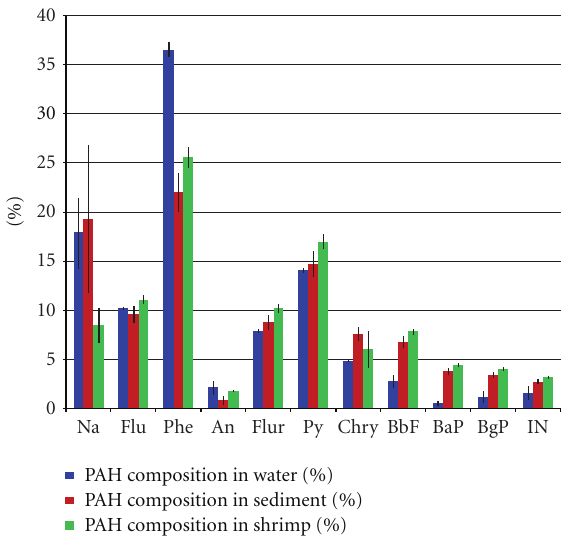
Figure 3: Mean percent PAH composition with 95% confidence